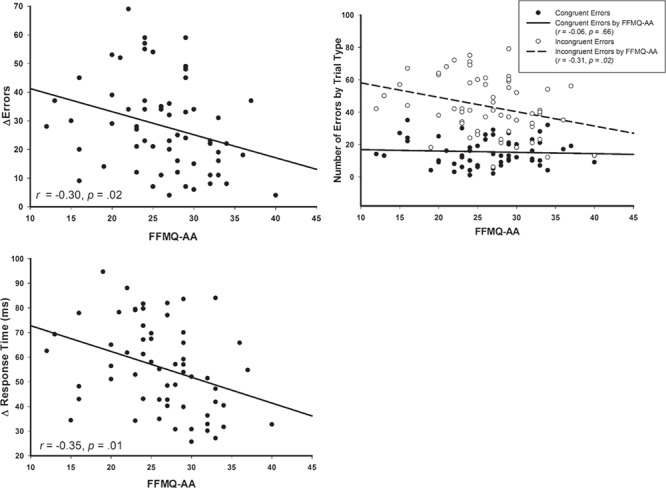
Scatterplots depicting behavioral performance as a function of trait mindfulness (FFMQ-AA). Top left: significant negative correlation between FFMQ-AA and number of errors elicited on incongruent trials (dashed line), but not congruent trials (solid line). As FFMQ-AA increases, number of errors committed on incongruent trials decreases. Top right: negative correlation between congruency difference (incongruent–congruent) in errors (Δ errors) and FFMQ-AA, such that as FFMQ-AA increases, Δ errors decreases. Bottom left: negative correlation between congruency difference (incongruent–congruent) in response time (Δ RT) and FFMQ-AA, such that as FFMQ-AA increases, Δ RT decreases.